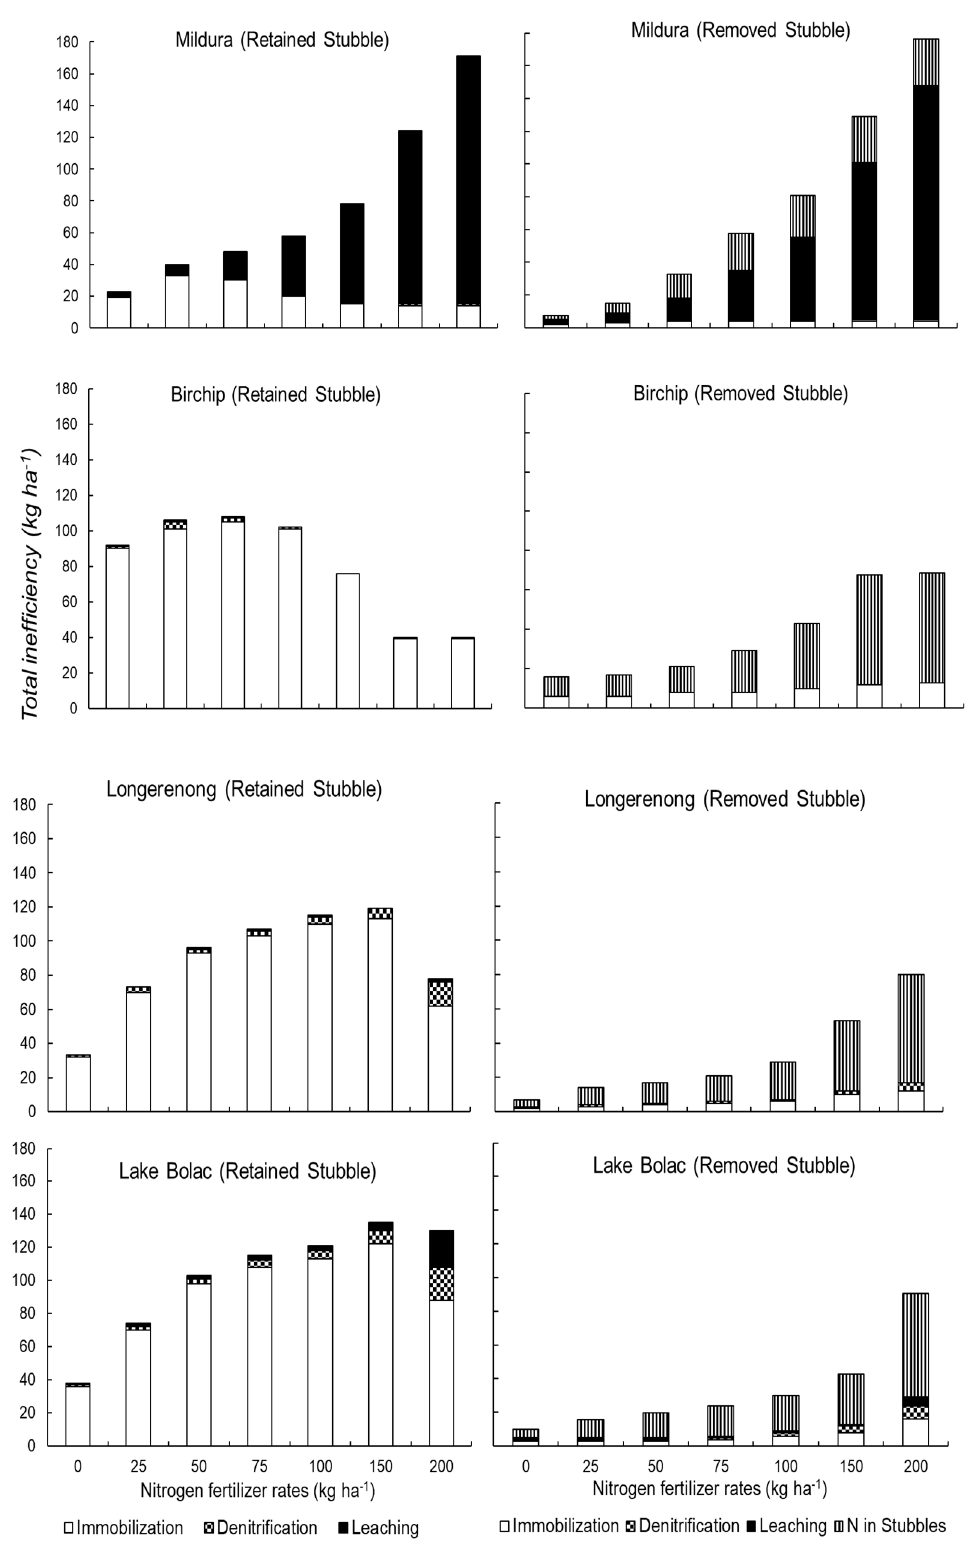
Figure 8. Total N inefficiency sources at different N rates with retained and removed stubble.